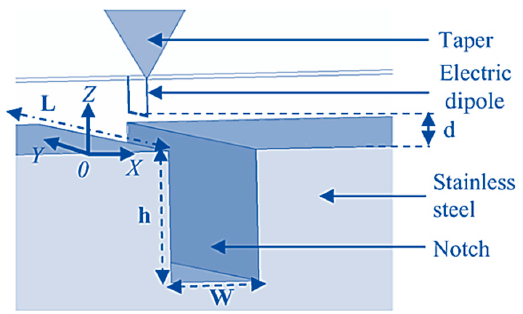
Figure 3. Photograph of the experimental setup (from [29]; copyright © 2008; reproduced with permission).